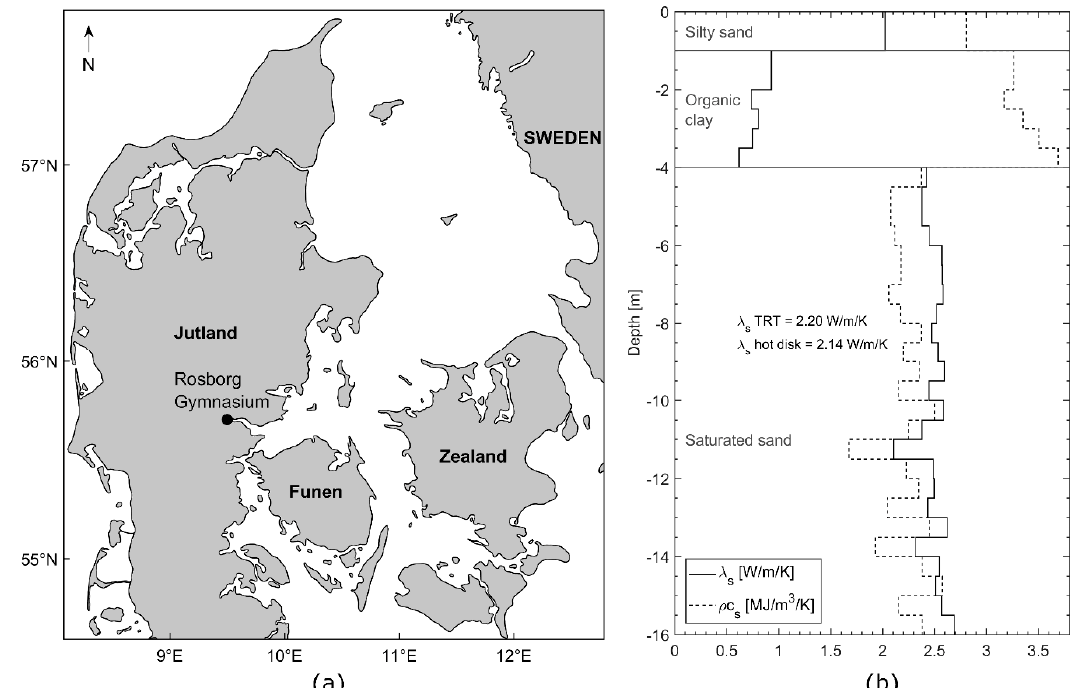
Figure 2. ( a ) Location of Rosborg Gymnasium in Vejle, Denmark. ( b ) Lithological profile from the field site at Rosborg Gymnasium including transient plane heat source measurements of soil thermal conductivity λ s and volumetric heat capacity pc s . TRT = Thermal Response Test. The × − scale in ( b ) is indicated in the legend.